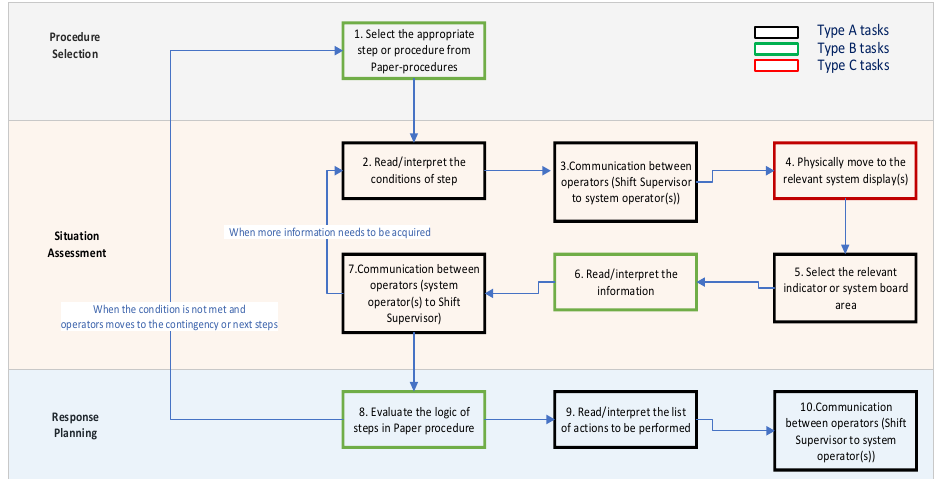
Figure 5. Diagnosis micro-tasks in the conventional MCR.